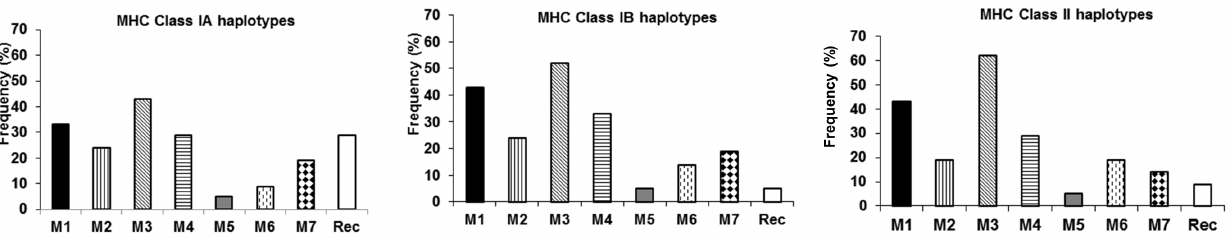
Figure 4. Frequency of MHC class IA, class IB and class II and recombinant haplotypes in animals included in the study. Animals carrying specific Mhc class I haplotypes. MHC class IA: M1=7, M2=5, M3=9, M4=6, M5=1, M6=2, M7=4, rec=6; frequency of MHC class IB: M1=9, M2=5, M3=11, M4=7, M5=1, M6=3, M7=4, rec=1; frequency of MHC class II: M1=9, M2=4, M3=13, M4=6, M5=1, M6=4, M7=3, rec=2 rec recombinant